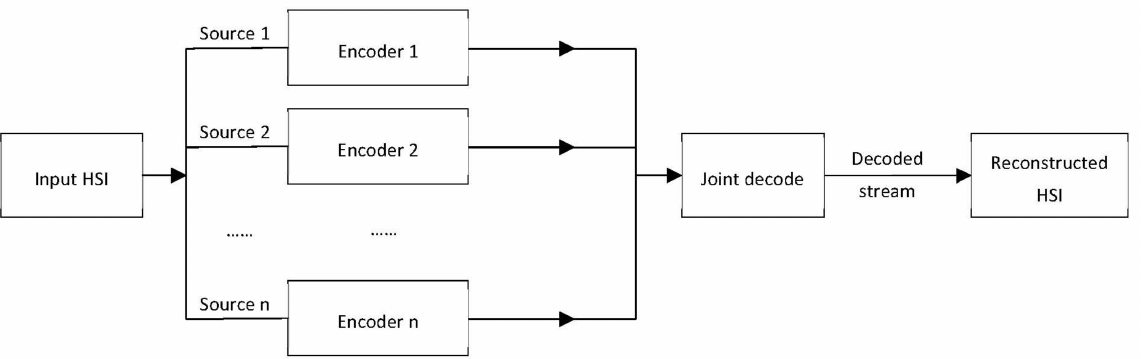
Figure 15. Conceptual framework of distributed source coding-based class of HSI compression